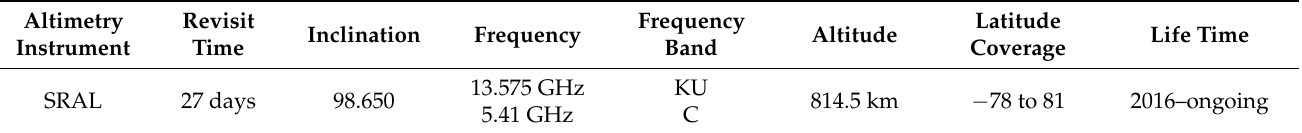
Table 1. Summary of Sentinel-3A altimeter operating characteristics